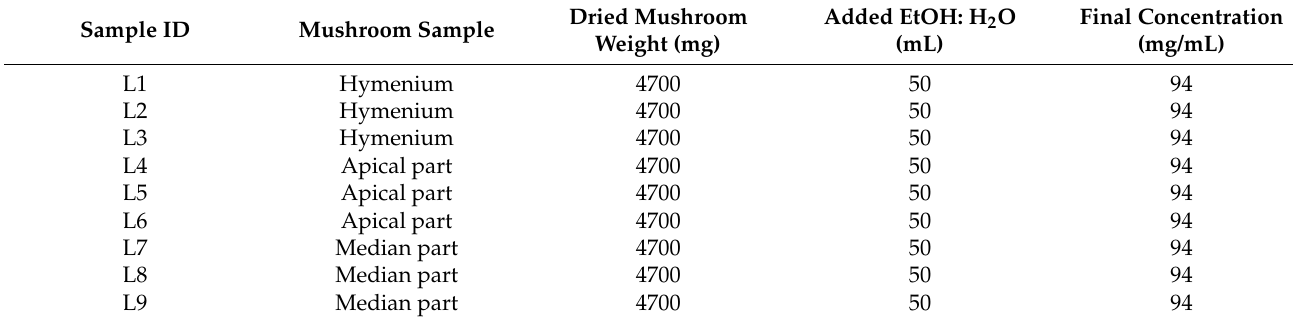
Table 9. Preparation of F. officinalis